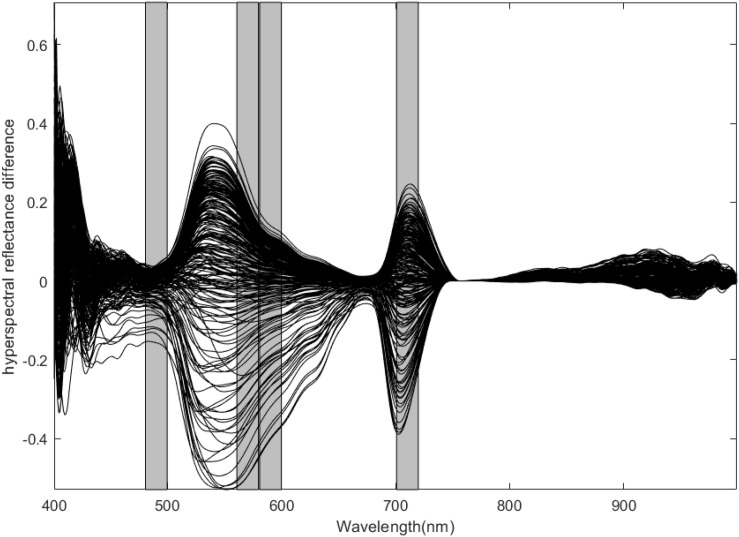
IRIV characteristic band interval.